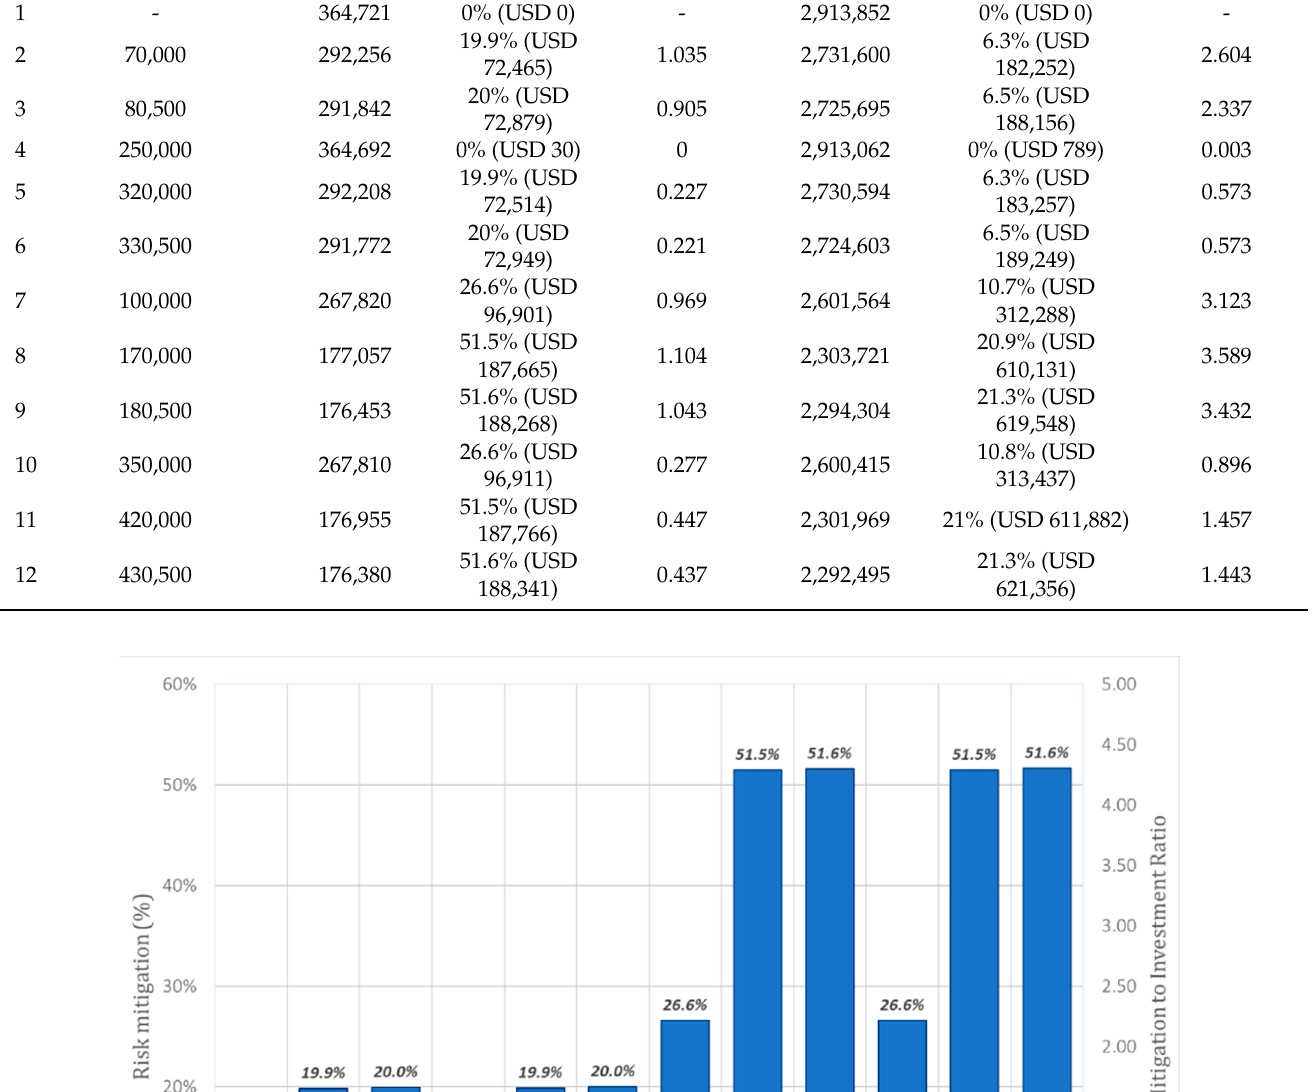
Figure 6. Analysis of the mitigation alternatives by the percentage of risk mitigation and RMIR case of the Bik’at HaYarden region.